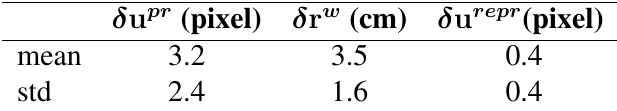
Table 5. Calibration accuracy of the network with only two cameras. The second row and the third row represent the mean and the standard deviation over all 40 test samples,